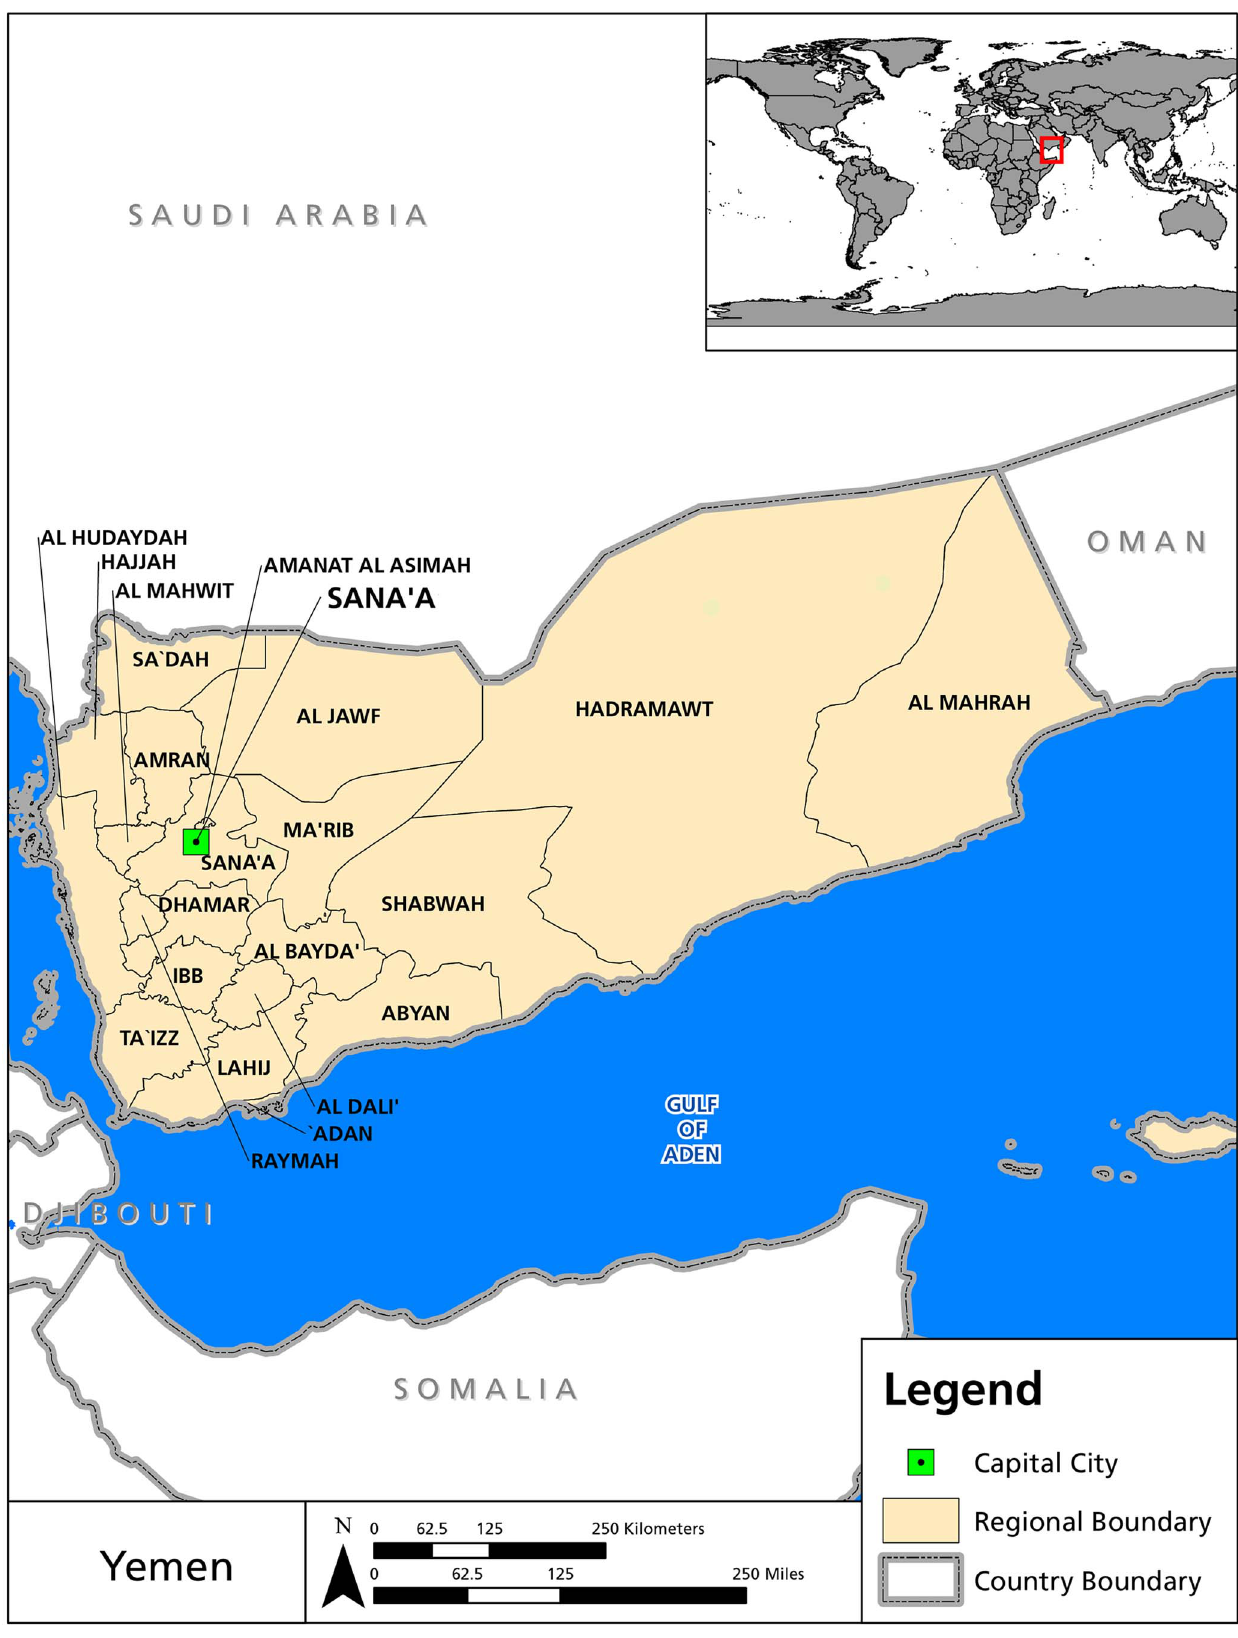
Fig. 1. Map of Yemen. (Original figure.) doi:10.1371/journal.pntd.0003292.g001 PLOS Neglected Tropical Diseases | www.plosntds.org 2 December 2014 | Volume 8 | Issue 12 |